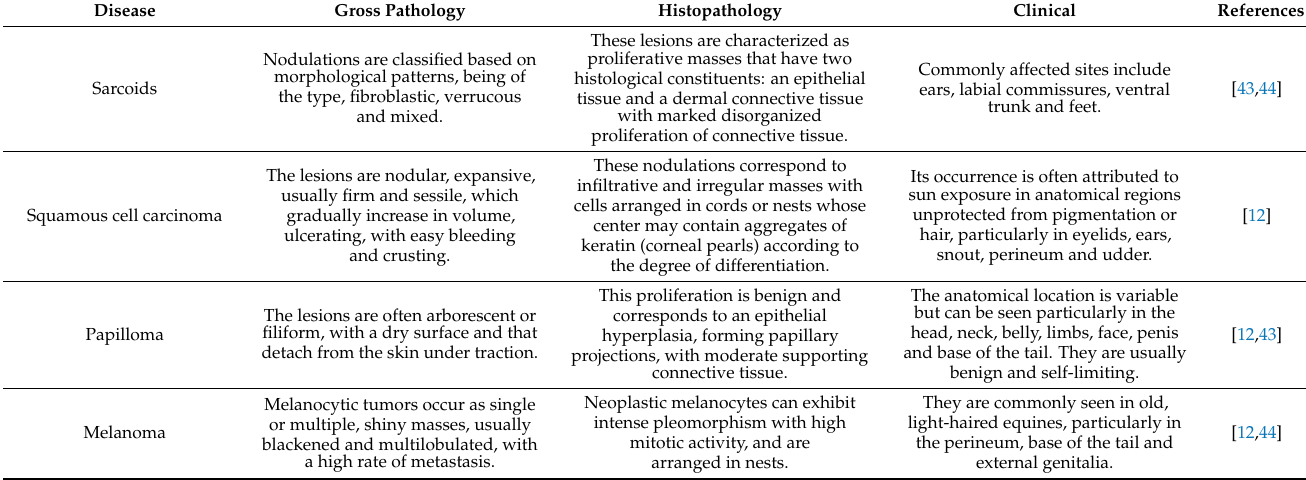
Table 3. Clinical and pathological characteristics of the main primary cutaneous neoplasms diagnosed in donkeys and mules.